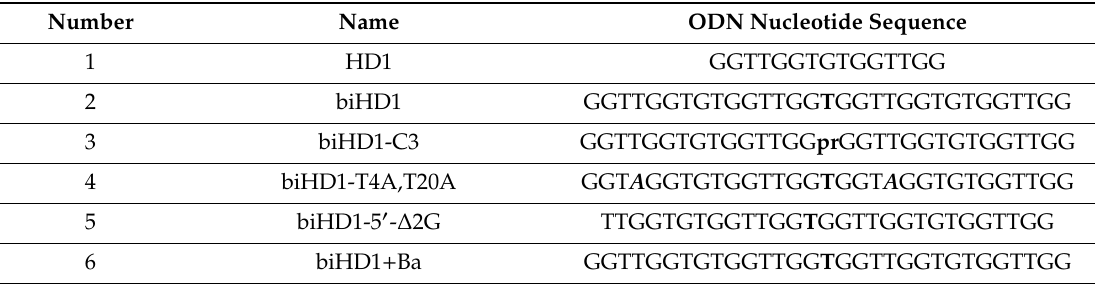
Table 1. Sequences of DNA oligonucleotide biHD1 and its derivatives. The changes are shown in bold; pr —1,3-propanediol residue.